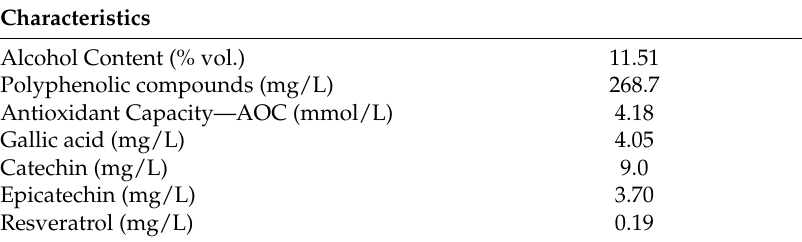
Table 2. Wine characteristics, including the content of alcohol and selected active substances. Müller Thurgau, produced by Vino Mikulov in 2004. Analysis was performed by High Performance Liquid Chromatography